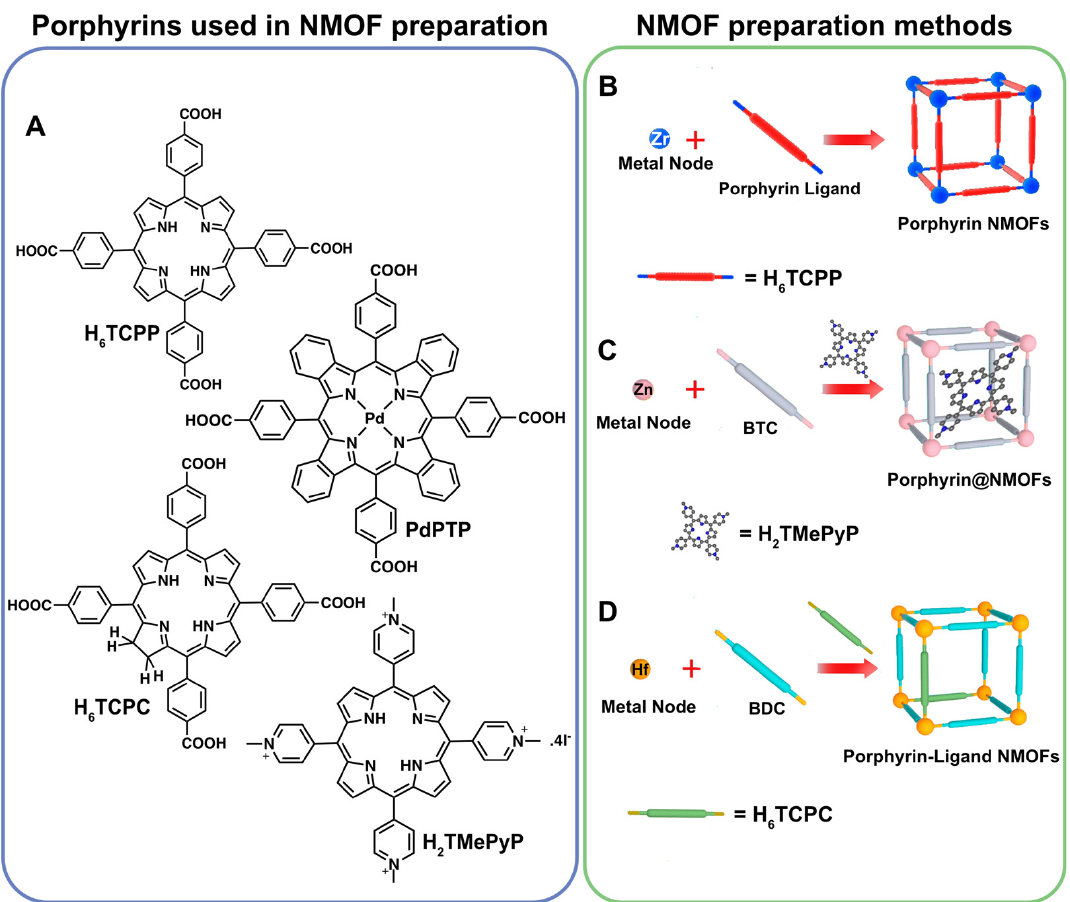
Figure 1. ( A ) Common porphyrin and porphyrin analogues used in the preparation of porphyrin NMOFs. ( B ) Porphyrin NMOFs preparation with a porphyrin ligand and a metal source. ( C ) Porphyrin inclusion in porous NMOFs. ( D ) Mixed ligand NMOF preparation in which porphyrins are a part of the synthesis. Reprinted/adapted with permission from Ref. [53] .